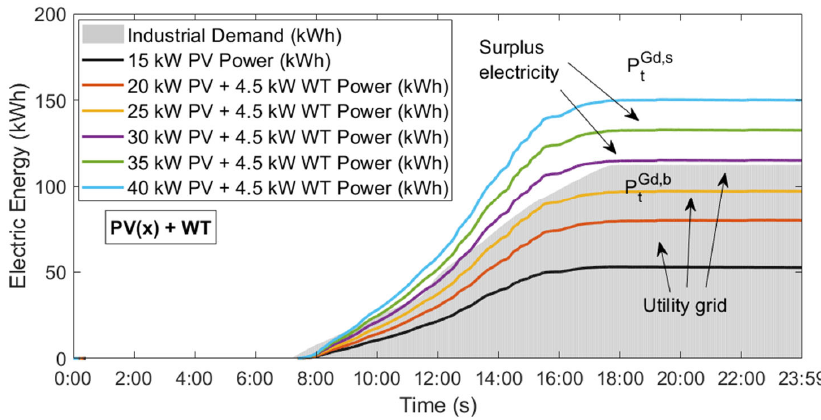
Figure 17. Sensitivity analysis with respect to PV capacity, Configuration 2.